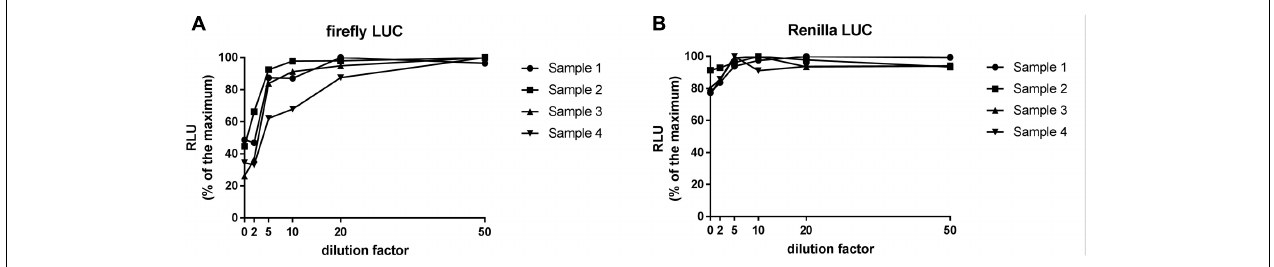
FIGURE 2 | Relative luminescence units emitted by firefly LUC (A) and Renilla LUC (B) activity across a range of dilution factors applied to Nicotiana benthamiana leaf extracts. Firefly LUC activity is inhibited by concentrated N. benthamiana leaf extracts. 20-fold dilution of a 5 mg per 100 µ L extract is required to diminish the inhibitory